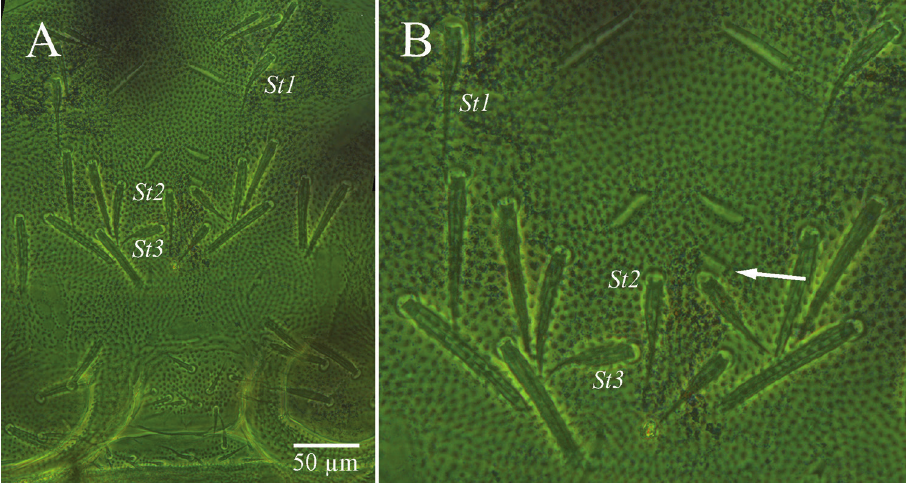
Figure 6. Neocarus spelaion sp. n.: A View of male sternitogenital region B Details of the duplicated lyrifissures. Abbreviations; St1 – 5 = sternitogenital setae.